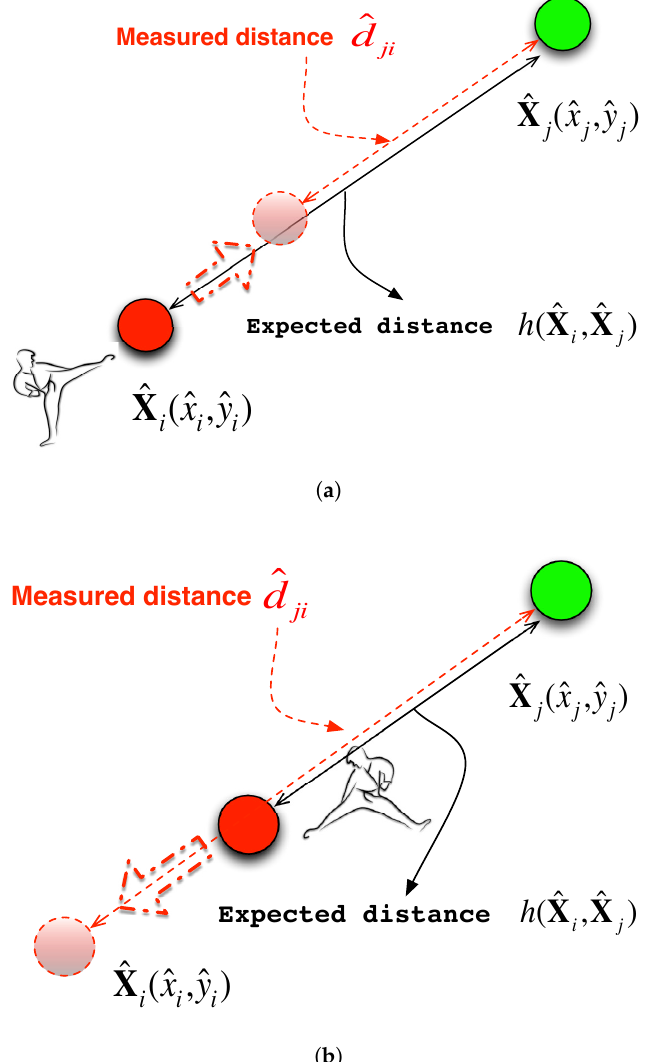
Figure 2. Illustrations of the intuition of the position adjustment in two scenarios: ( a ) when measured distance ˆ d is smaller than expected distance, kick it closer; ( b ) when measured distance ˆ d is larger than expected distance, kick it